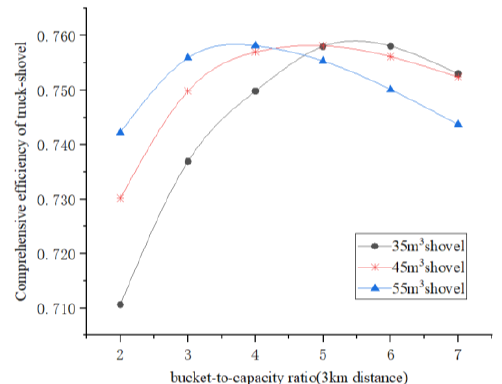
Figure 2. Relationship curves at 3 km transport distance.